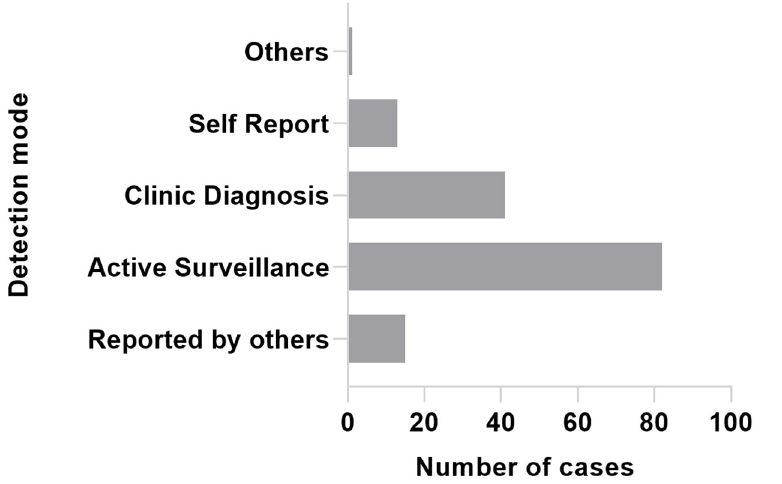
Fig 3. Detection modes of pediatric leprosy new cases in China, from 2011–2020.